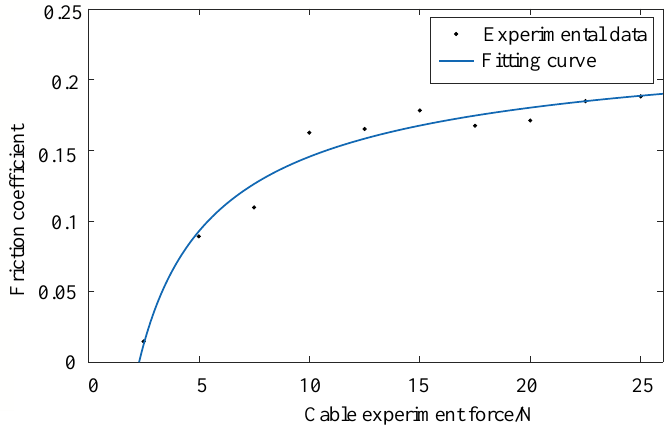
Figure 10. Friction coefficient of NSECA under different rope tensions.